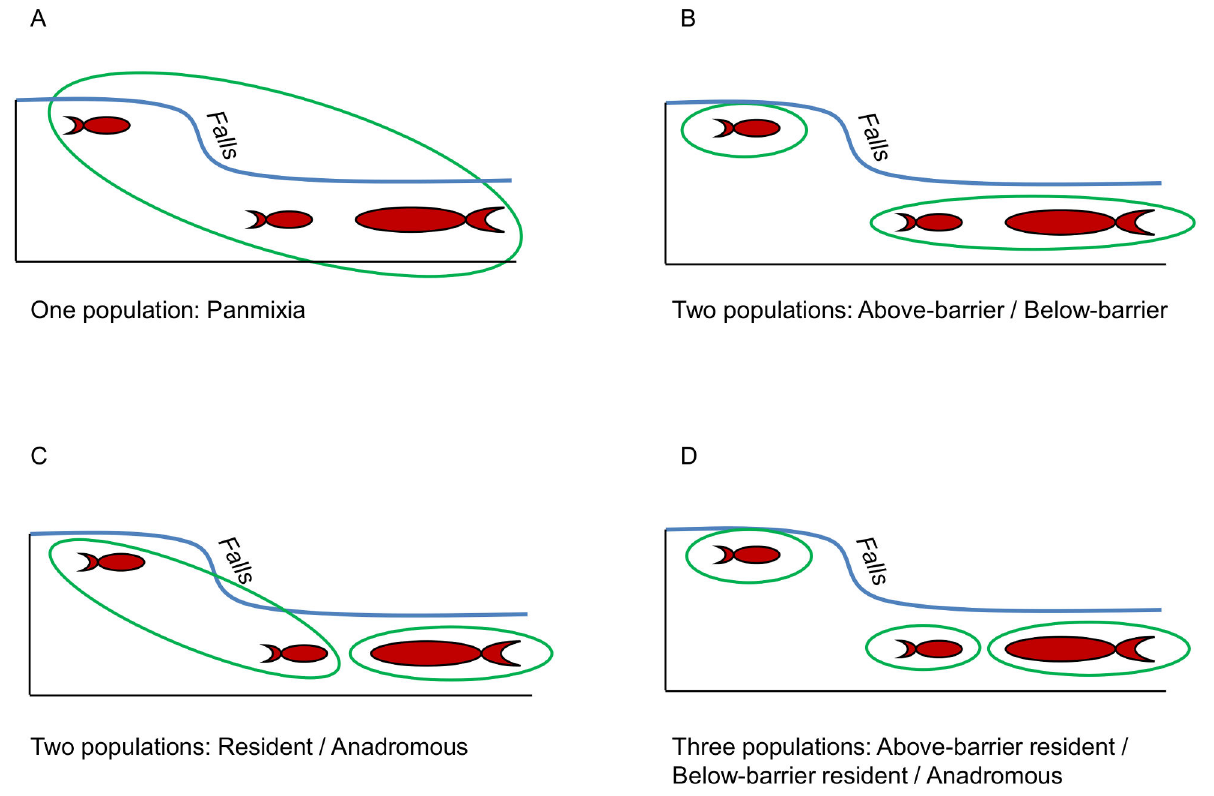
Figure 2. Pictorial representation of the hypothetical population structures tested for resident and anadromous O. mykiss samples. The small and large fish icons represent resident and anadromous O. mykiss , respectively, the falls represent a barrier to upstream migration, and the green ovals encompass the life-history type and location of fish considered as a single population for each scenario. For the Skokomish River, which does not contain a barrier to migration, only the one population, panmixia (A), and two population, resident / anadromous (C) scenarios were